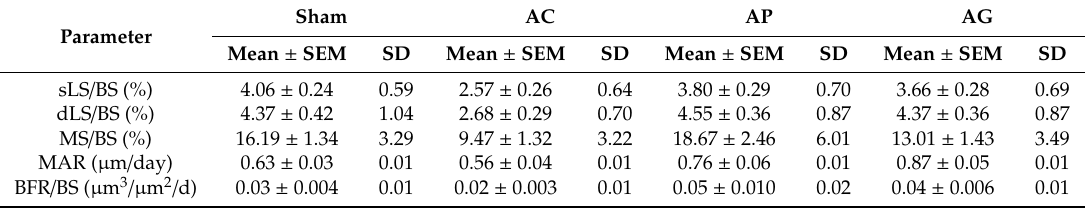
Table 3. Mean values, standard error of mean (SEM), and standard deviation (SD) of dynamic histomorphometric